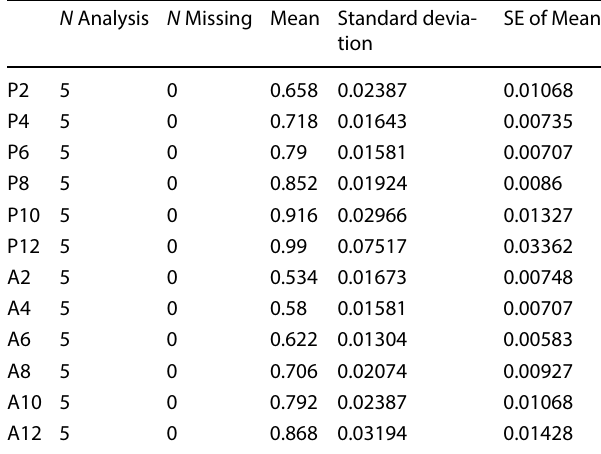
N Analysis N Missing Mean Standard devia-